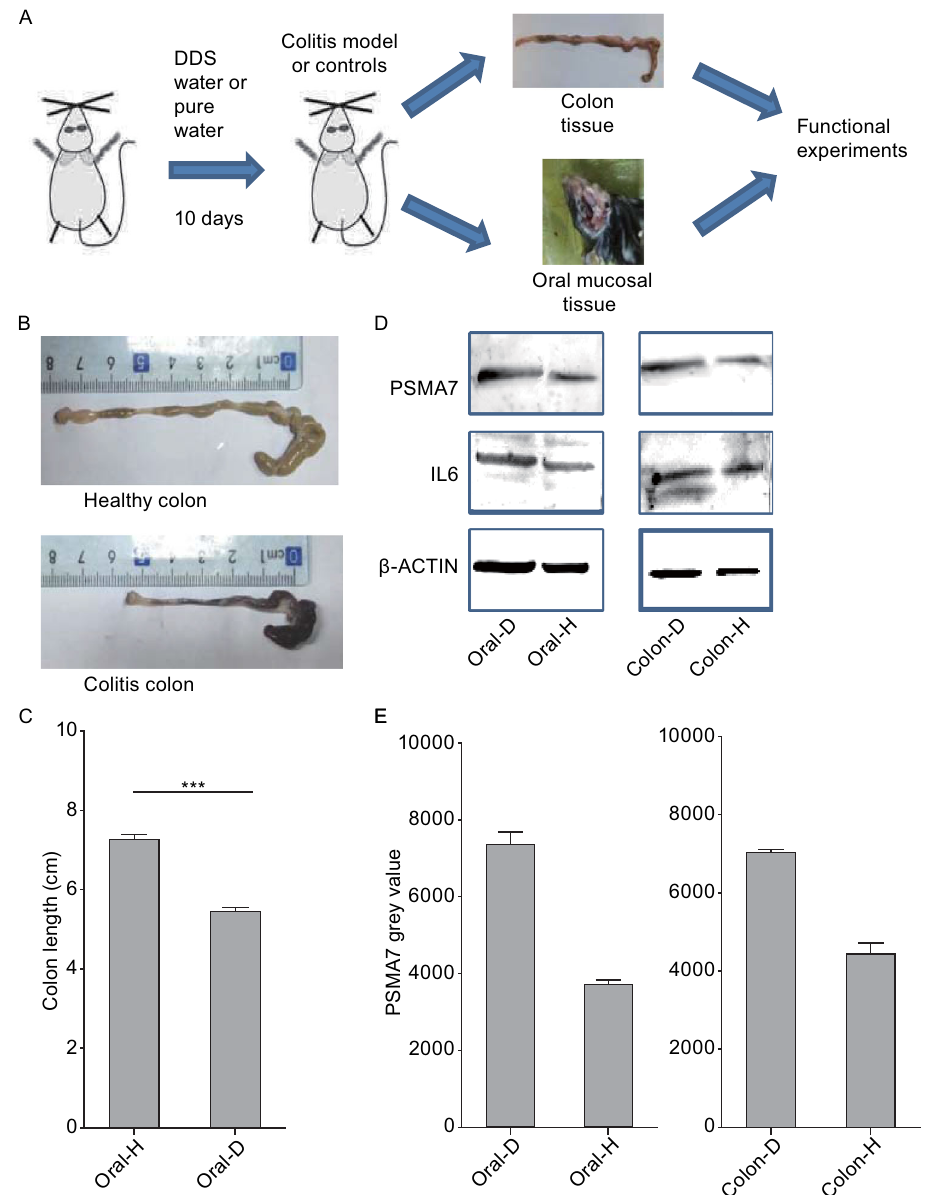
Figure 5. Expression pro fi le of PSMA7 in animal studies. (A) Flow chart of the animal study. (B) Colon sections obtained from mice were analyzed for their outward appearance. (C) Colon length of the colitis model mice and control groups. (D) Proteins from the tissue of colon and oral cavity were extracted. The expression of PSMA7 is higher in IBD groups both in the colon and oral